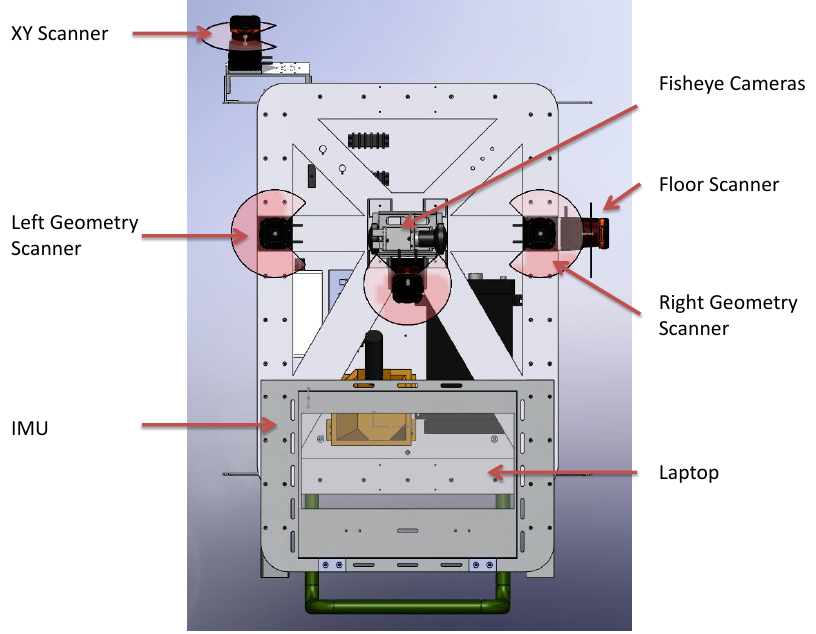
Figure 1. A CAD model of the ambulatory human-mounted backpack system used for data